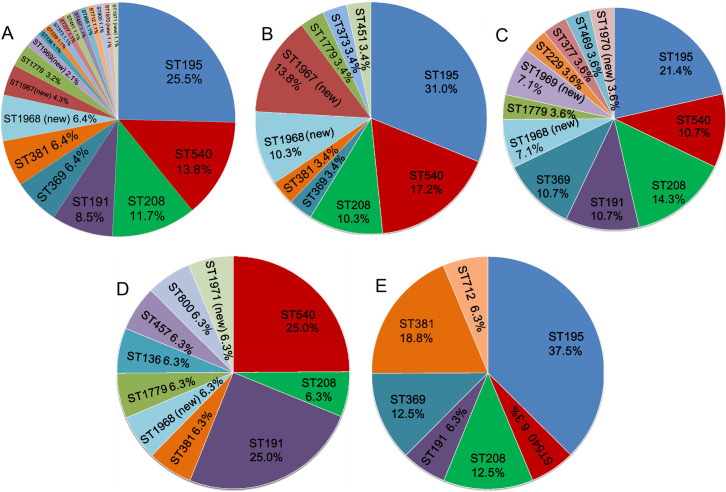
MLST population analysis over the different years.(A) ST in all 94 isolates. (B) ST distribution in 2016. (C) ST distribution in 2017. (D) ST distribution in 2018. (E) ST distribution in 2019.